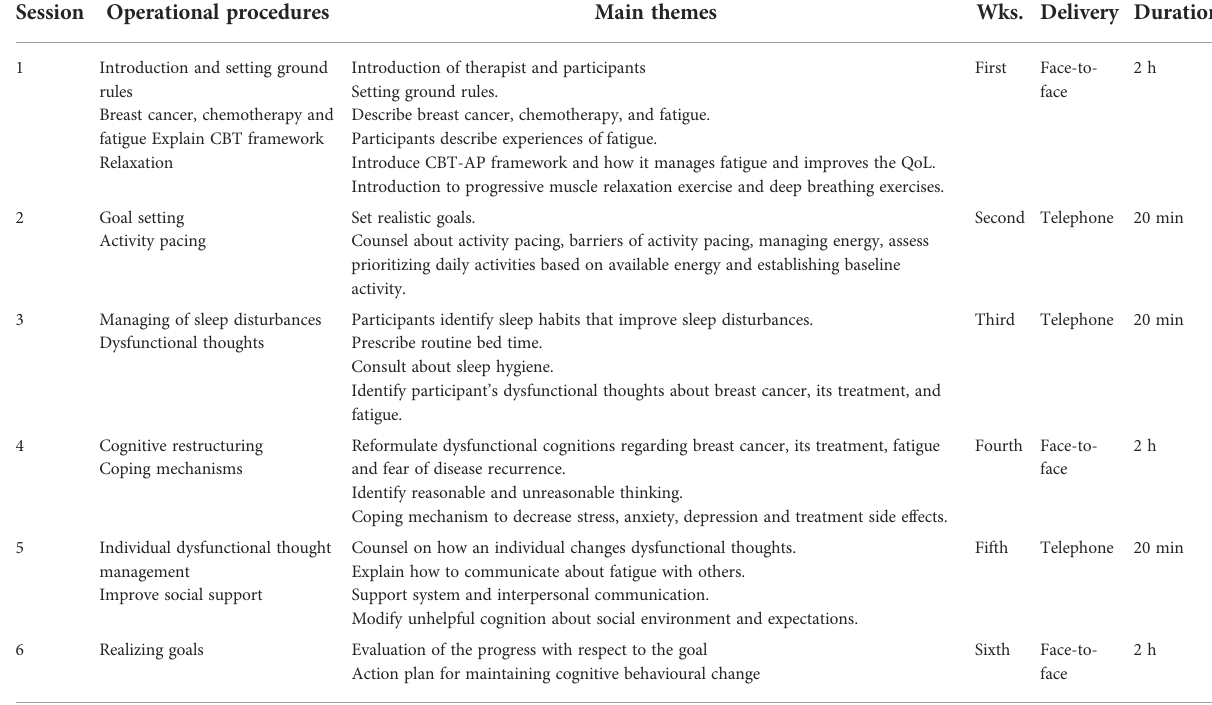
TABLE 1 Cognitive behavioural therapy integrated with activity pacing (CBT-AP) outline for breast cancer patients undergoing chemotherapy. Session Operational